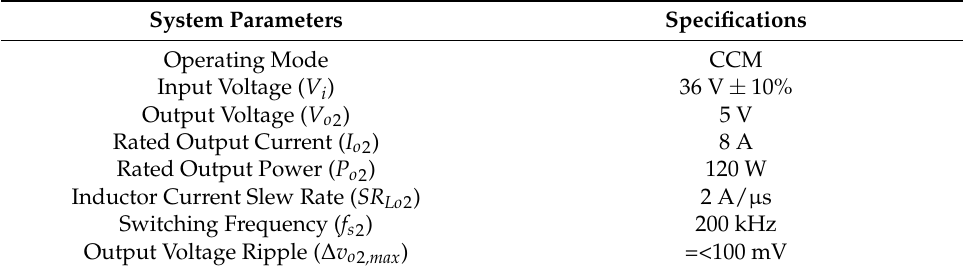
Table 2. First secondary output specifications.